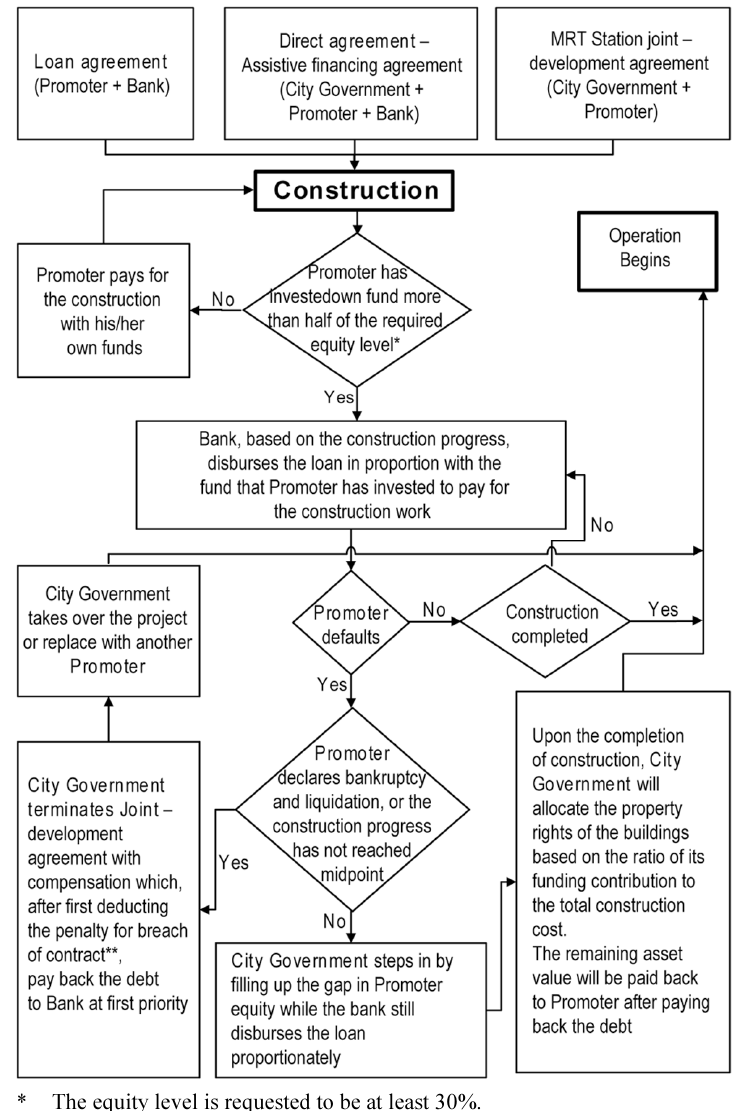
Fig. 3. Implementation procedures of assistive financing mechanism of Taipei MRT station joint-development